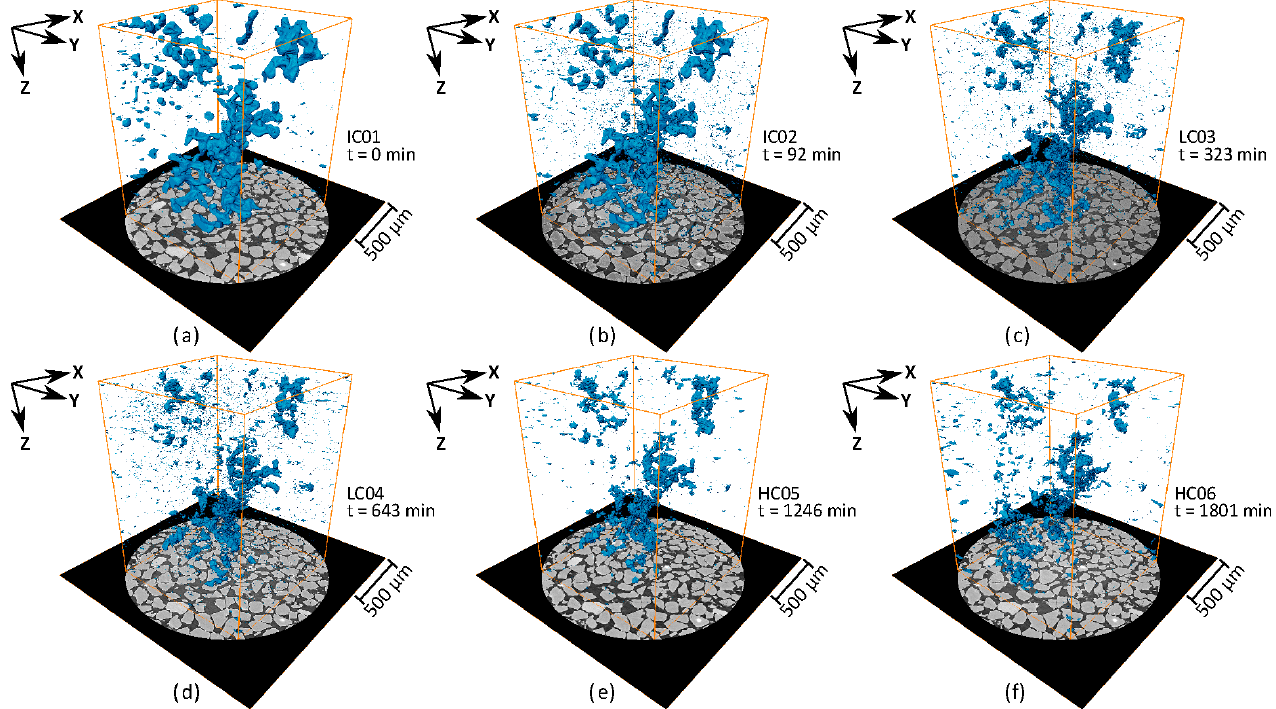
Figure 13. XCT-derived 3D views of CH 4 gas depletion during hydrate formation, with t denoting cooling time in minutes after reaching 2 °C: ( a ) t = 0, ( b ) t = 92, ( c ) t = 323, ( d ) t = 643, ( e ) t = 1246, ( f ) t = 1801. Segmentation carried out using a RootPainter U-Net model trained on the low-contrast LC03 data.